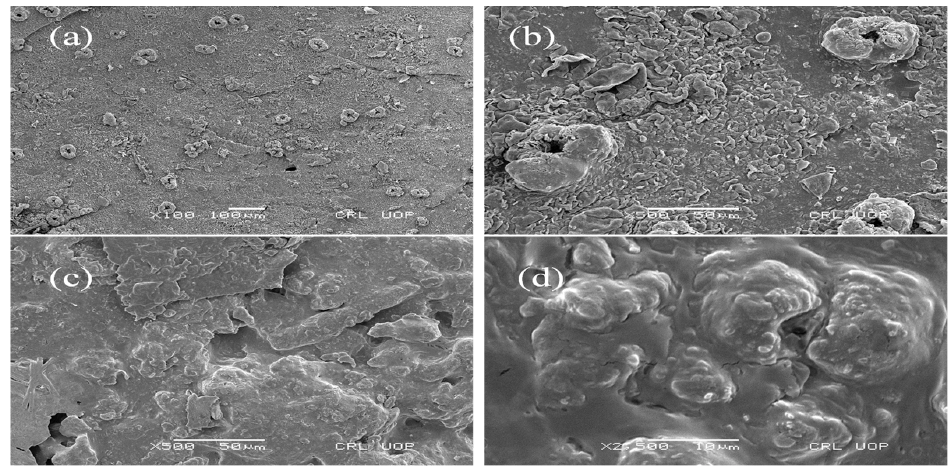
Figure 5. SEM photomicrographs of unloaded BA hydrogel ( a , b ) and Ins-Mmt-BA hydrogel NC ( c , d ).